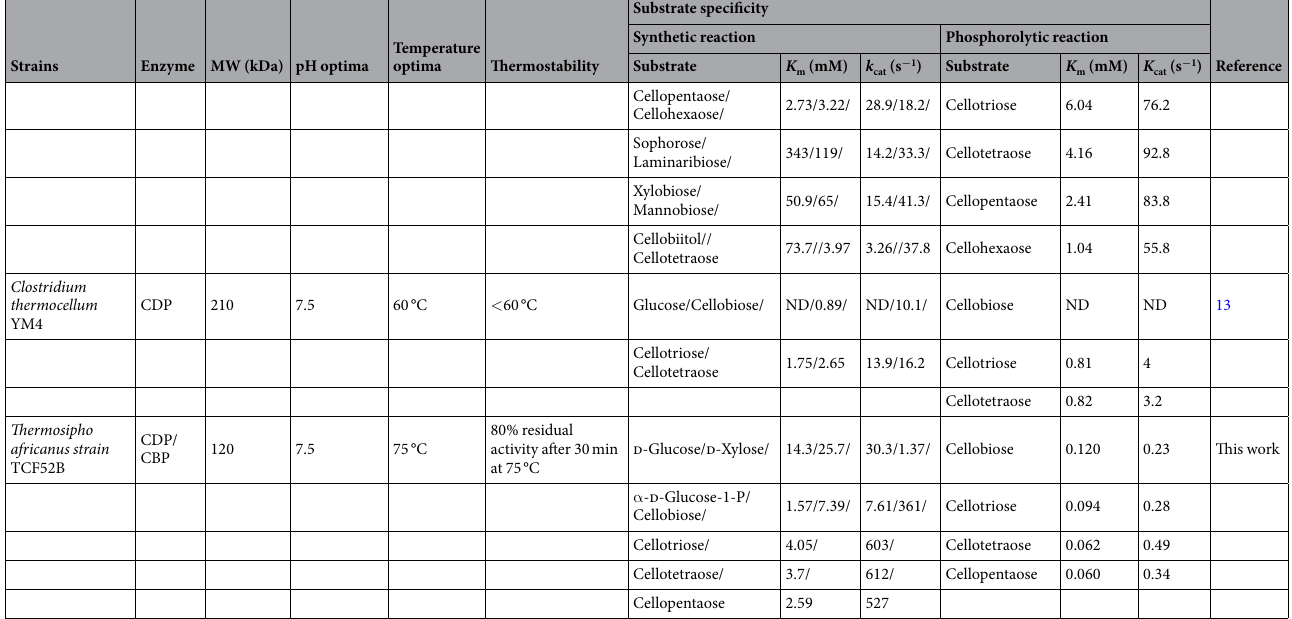
Phosphorolytic enzymes like CBPs and CDPs had advantages in oligosaccharides synthesis over chemical catalysts because they have both stereoselectivity and regiospecificity 37, 38 . TaCDP had high synthetic activities towards monosacchrides, disaccharides, and long-chain oligosaccharids, making it a valuable biocatalyst for cost-effective enzymatic synthesis of various oligosaccharides.